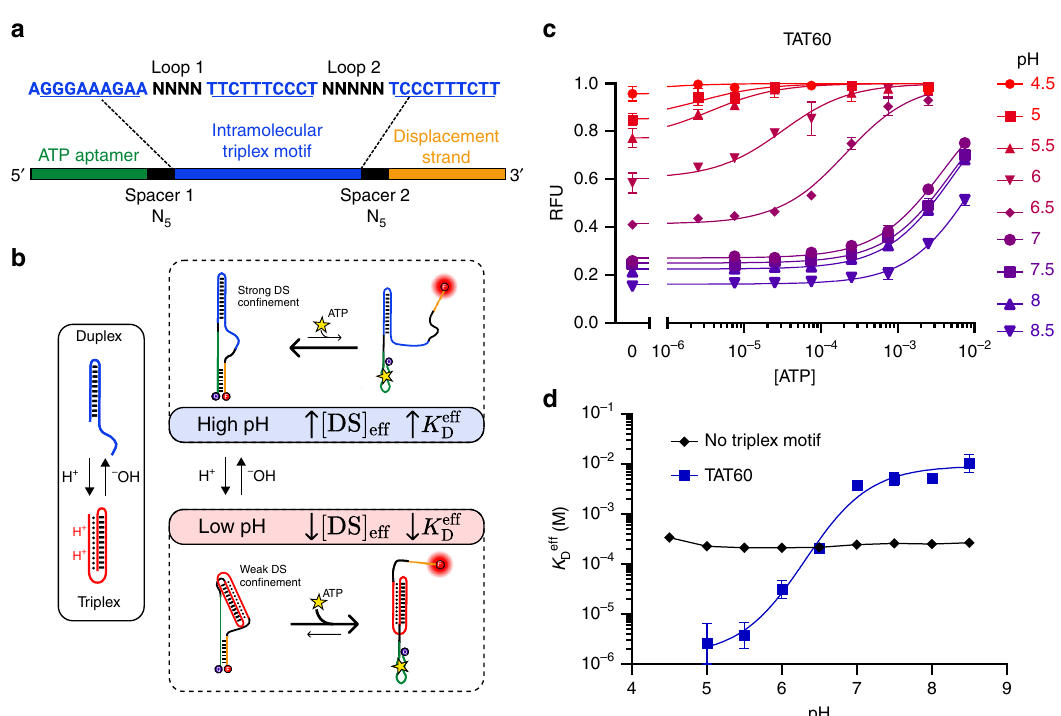
Fig. 1 Design of an ATP aptamer for selective binding at low pH. a An intramolecular triplex motif is inserted into the linker domain, which connects the ATP aptamer and displacement strand (DS). The unconstrained loop and spacer sequences are optimized to minimize interference with the aptamer secondary structure. The construct shown here is TAT60, re fl ecting the 60% TAT composition of the triplex motif. b A simpli fi ed model for pH-dependent binding. pH dependence is achieved via conformational changes in the triplex motif, which increase the effective DS concentration near the aptamer ([DS] eff ) at high pH, thereby inhibiting ATP binding and fl uorescent signaling. A complete three-state model of the pH-dependent binding mechanism is given in Supplementary Fig. 3. c ATP binding curves for the TAT60 construct show a strongly pH-dependent shift in af fi nity. d A standard ATP intramolecular strand displacement aptamer construct with no triplex motif exhibits no pH sensitivity, whereas insertion of the triplex-based linker induces dramatic pH sensitivity. Data points and error bars in c show the means and standard deviations of n = 3 independent experiments. Data points and error bars in d show the best fi t values and standard deviations extracted from Langmuir isotherm fi ts to binding curve data from n = 3 independent experiments using nonlinear least squares fi tting. Source data are provided as a Source Data fi